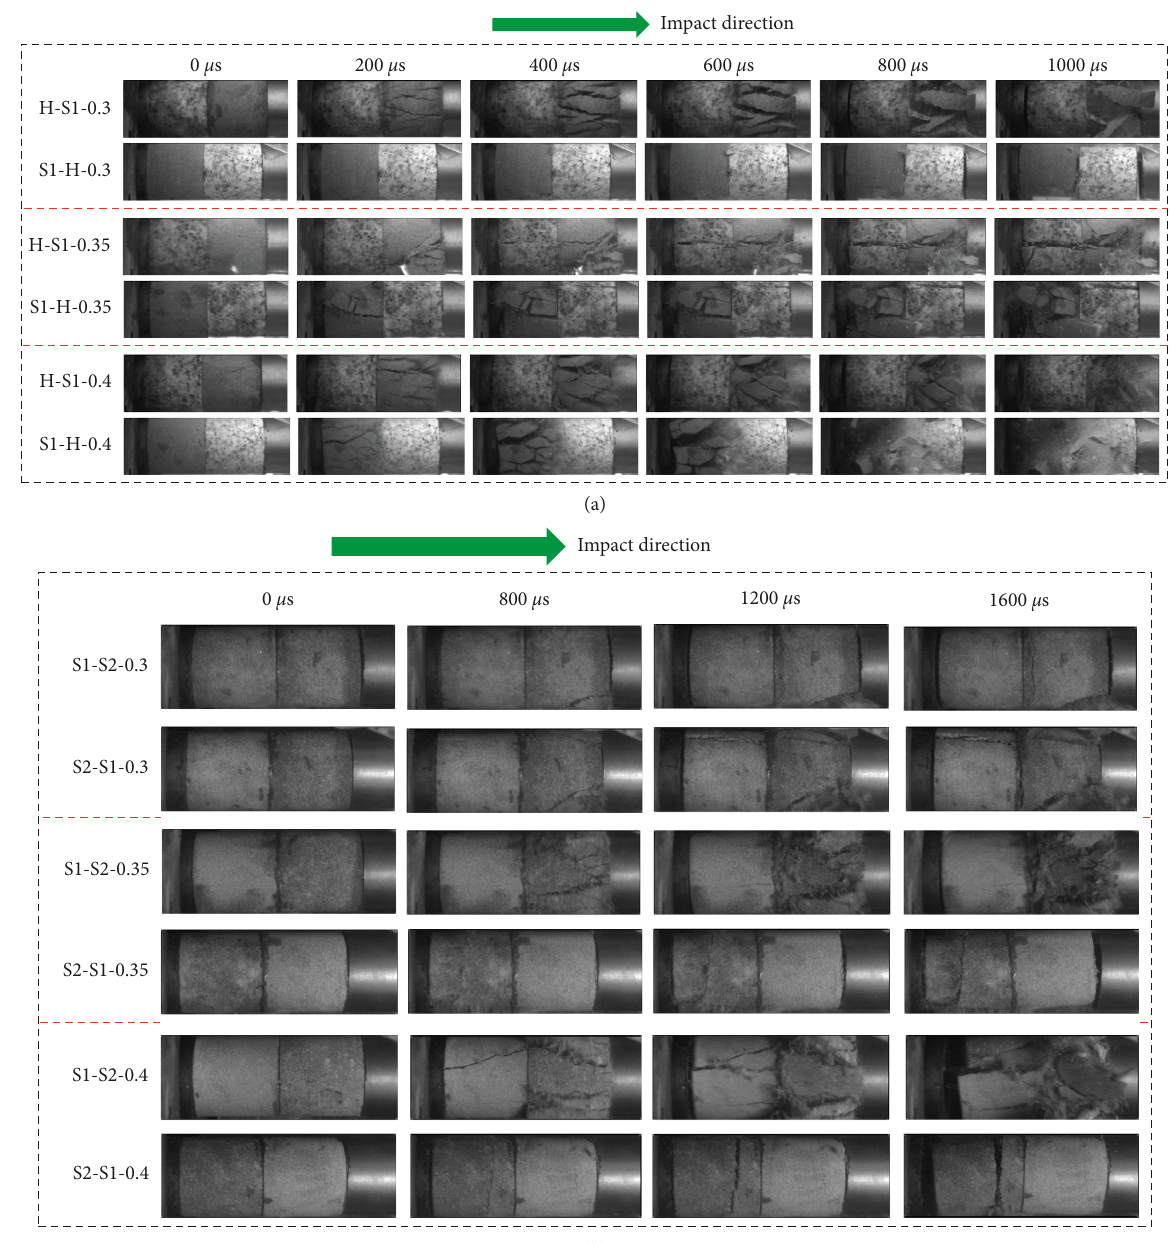
Figure 10: Failure processes of composite specimens under different strain rate loadings. (a) H-S1 and (b)